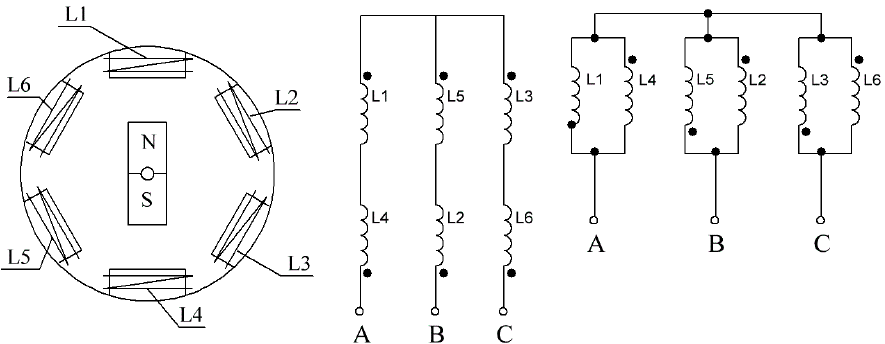
Figure 4. Three-phase generator.